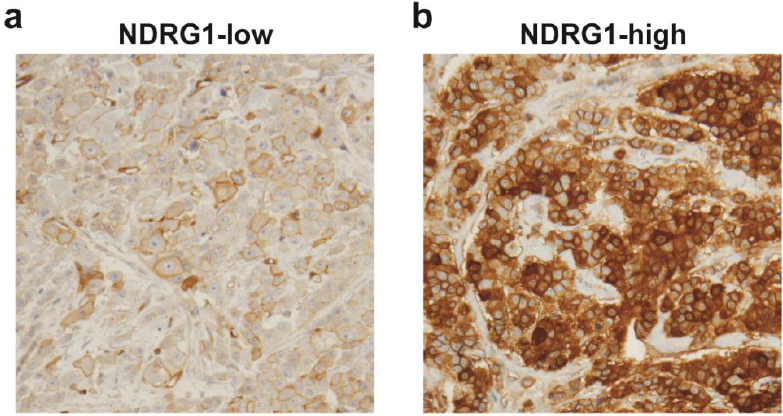
Figure 1. Immunohistochemical staining of N-myc downstream-regulated gene 1 (NDRG1) in inflammatory breast cancer (IBC) tumors. Representative images of NDRG1 immunostaining of ( a ) an NDRG1-low IBC tumor and ( b ) an NDRG1-high IBC tumor.